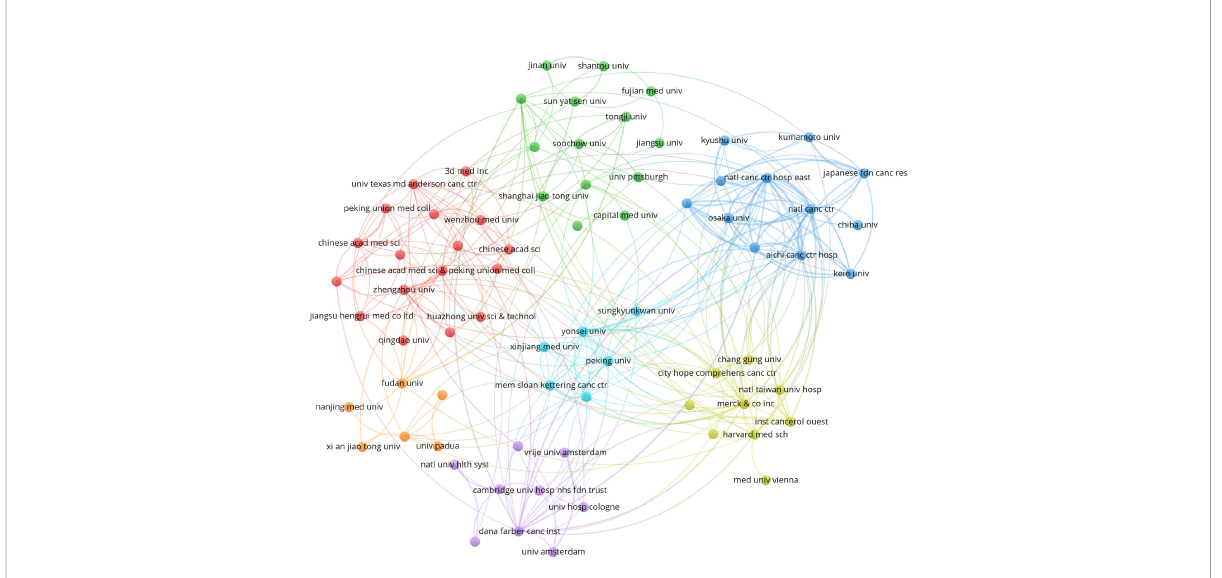
FIGURE 4 The co-authorship network visualization map of